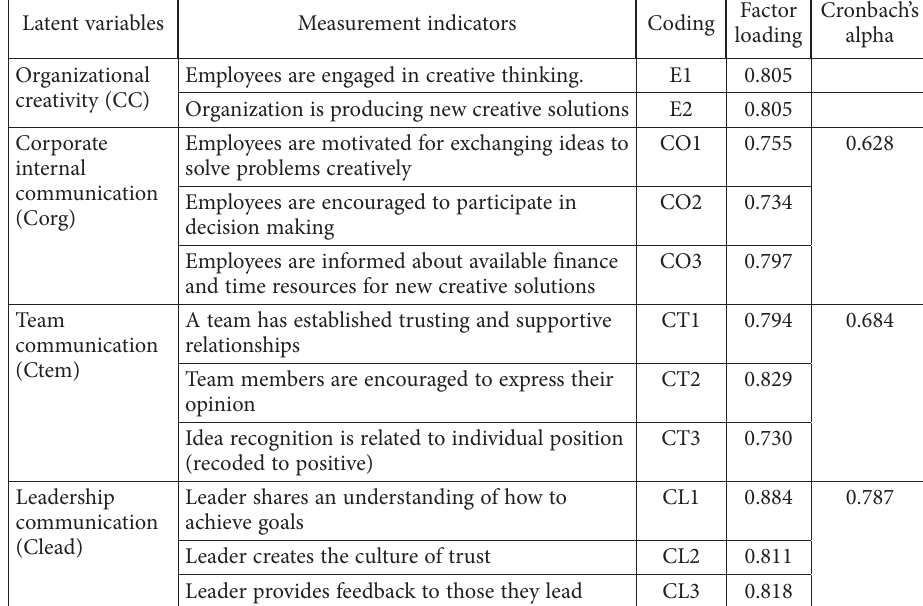
Table 1. The research construct and construct reliability (source: created by authors) Latent